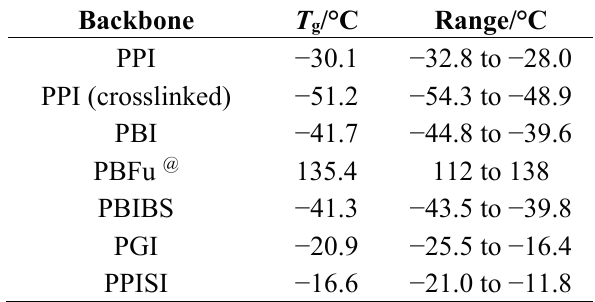
Table 5. T g of UPE backbones. @, T g not observed, value is T m